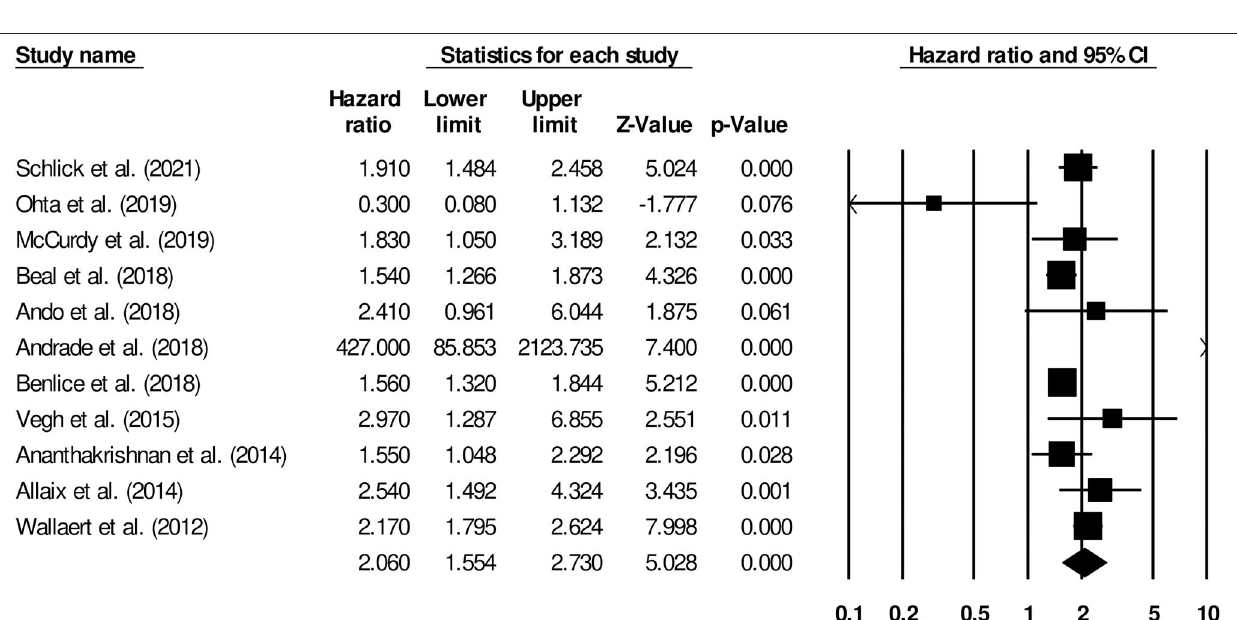
FIGURE 5 | Forest plot for studies evaluating female gender as a risk factor of venous thromboembolism in patients with inflammatory bowel disease. The hazard ratios are presented as black boxes whereas 95% confidence intervals are presented as whiskers. A small hazard ratio represents lower risks of venous thromboembolism associated with female gender, and a higher hazard ratio represents higher risks of venous thromboembolism associated with female gender in patients with inflammatory bowel disease.